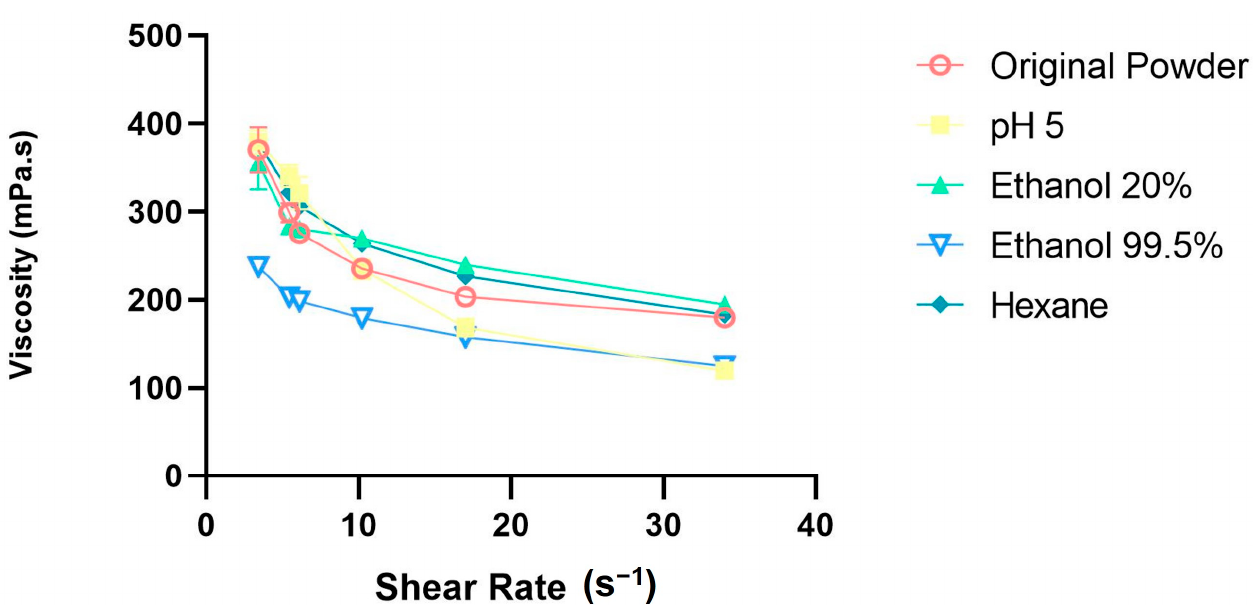
Figure 9. Pasting properties of cricket powders and treatments: evaluation of viscosity.